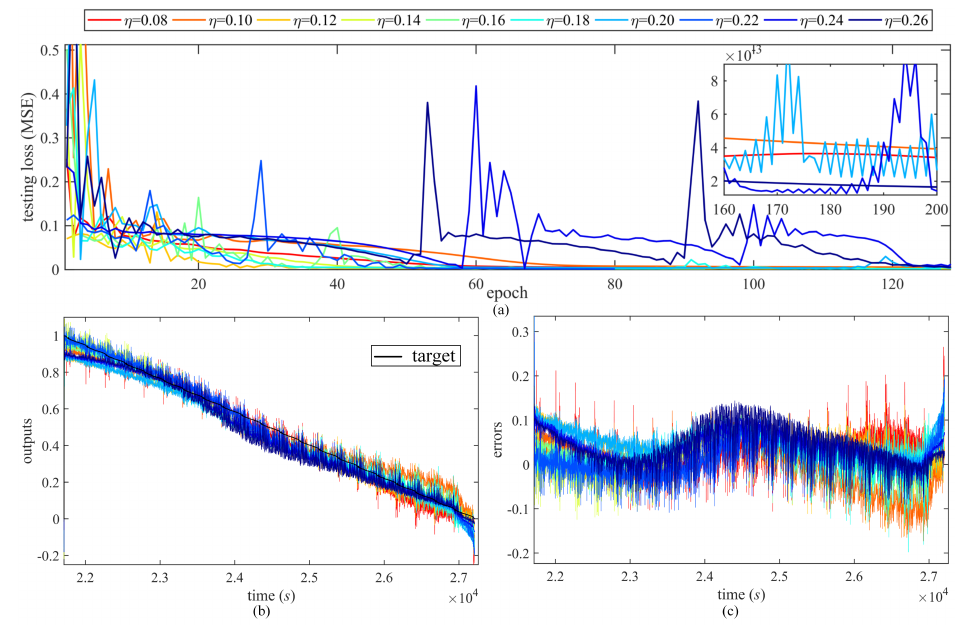
Figure 10. Sensitivity of the learning rate, η = 0.08:0.02:0.26, ( a ) testing loss, ( b ) testing outputs, and ( c ) testing